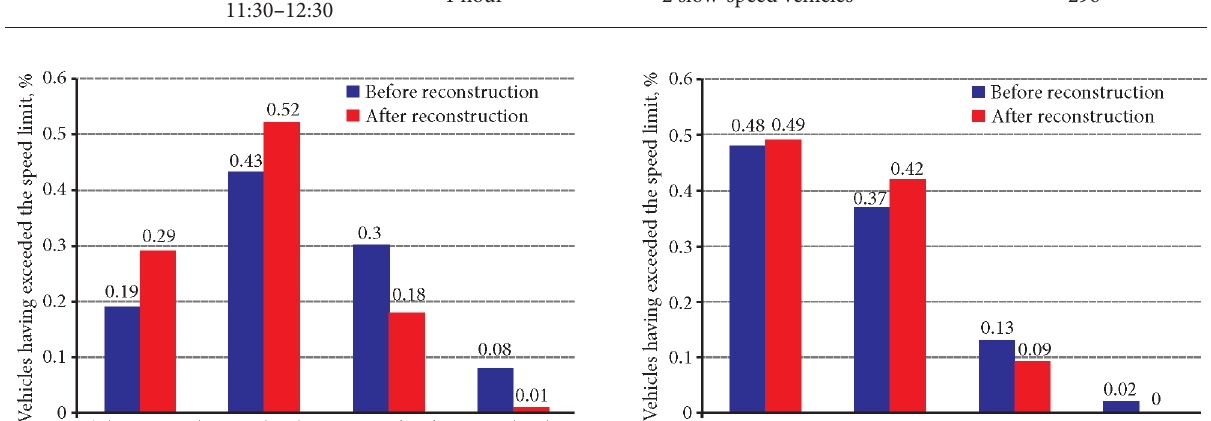
Fig. 8. Distribution scheme of prevailing speeds in the intersection zone of roads A8 (on the left) and A16 (on the